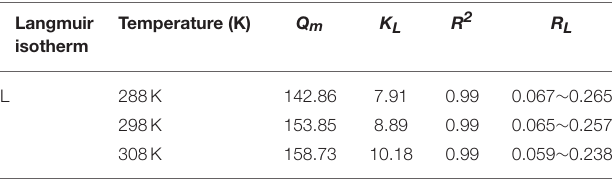
TABLE 3 | Langmuir isotherm parameters for iodine adsorption over JLUE-COP-3. Langmuir Temperature (K) isotherm